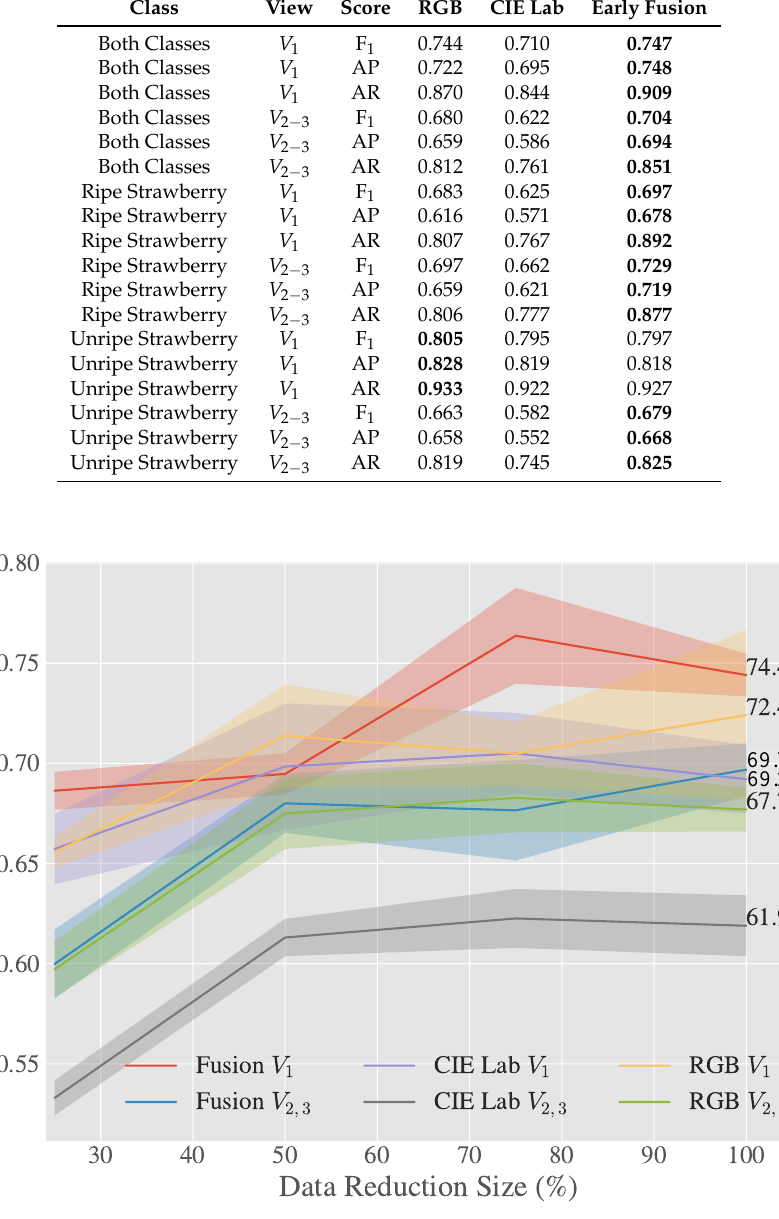
Figure 6. F 1 Score for 50% intersection over union on V 1 and V 2 + V 3 validation data